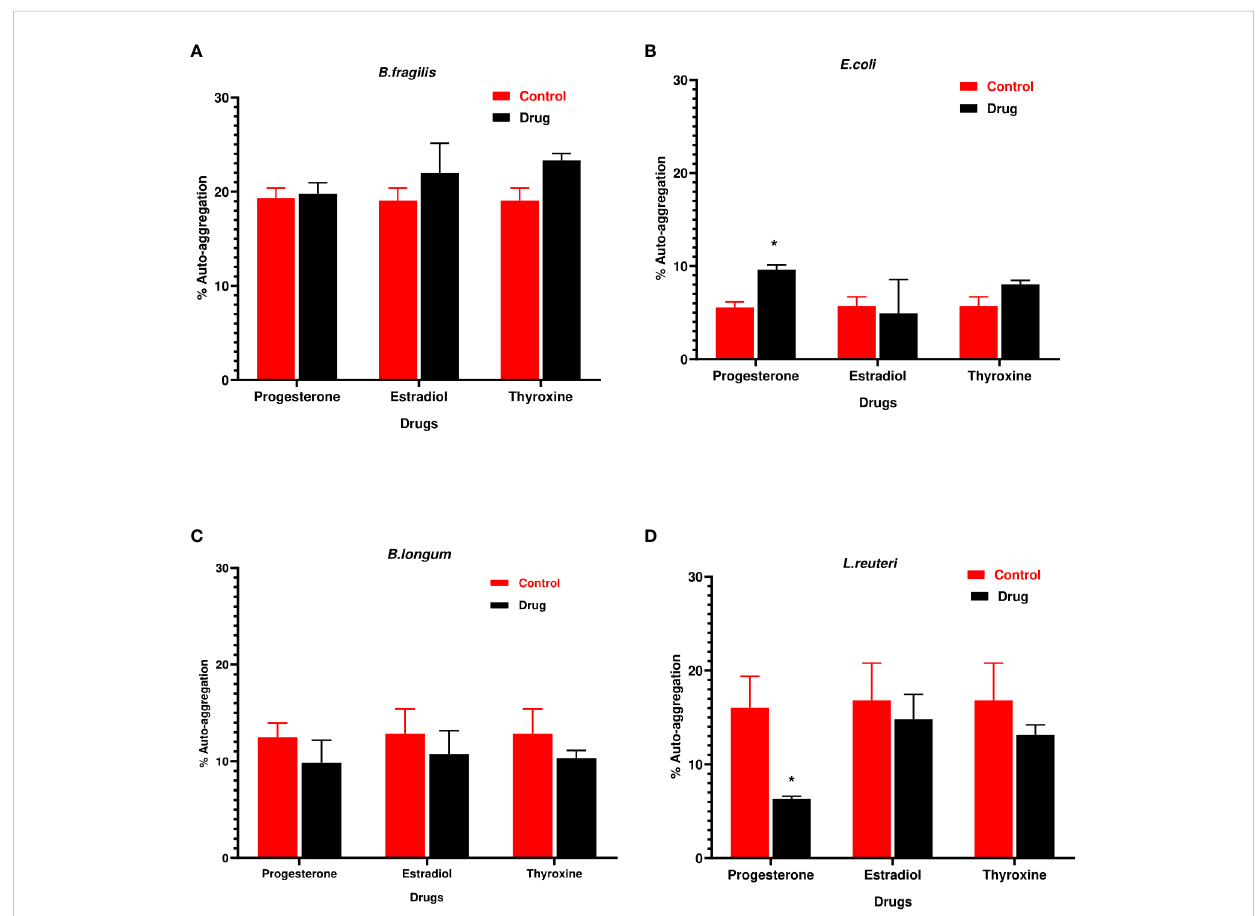
FIGURE 2 Auto-aggregation of bacteria with hormonal drugs. Change in percentage auto- aggregation of (A) B. fragilis ; (B) E. coli; (C) B. longum; (D) L. reuteri after incubation with hormonal drugs at 37°C for 60 min. Values were expressed as the mean of the percentage of three experiments with error bars (SE). Tested hormonal drugs include progesterone, ethinyl estradiol, and L-thyroxine in their intestinal concentrations, 211.99, 0.562, and 0.0481µM, respectively. Control represents the bacteria in addition to DMSO. Multiple unpaired t-tests along with Holm-S ̌ ı ́ da ́ k for multiple corrections were used to statistically compare the effect of different drugs on bacterial auto-aggregation. * Signi fi cant difference